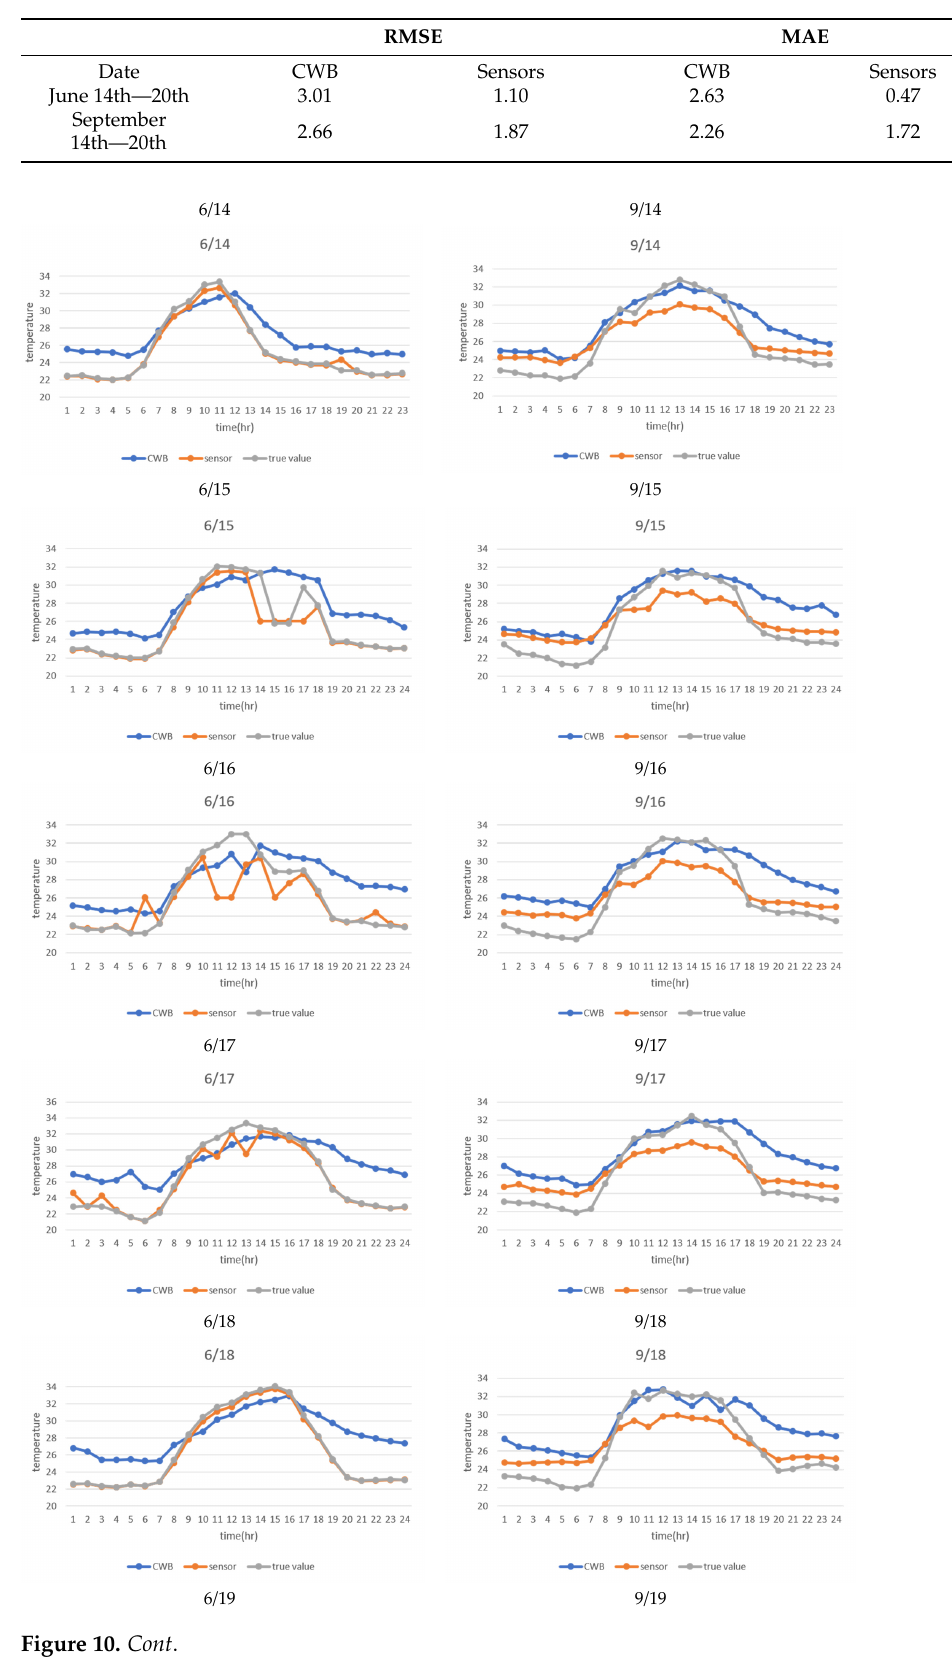
Table 4. RMSE and MAE (hourly temperatures).